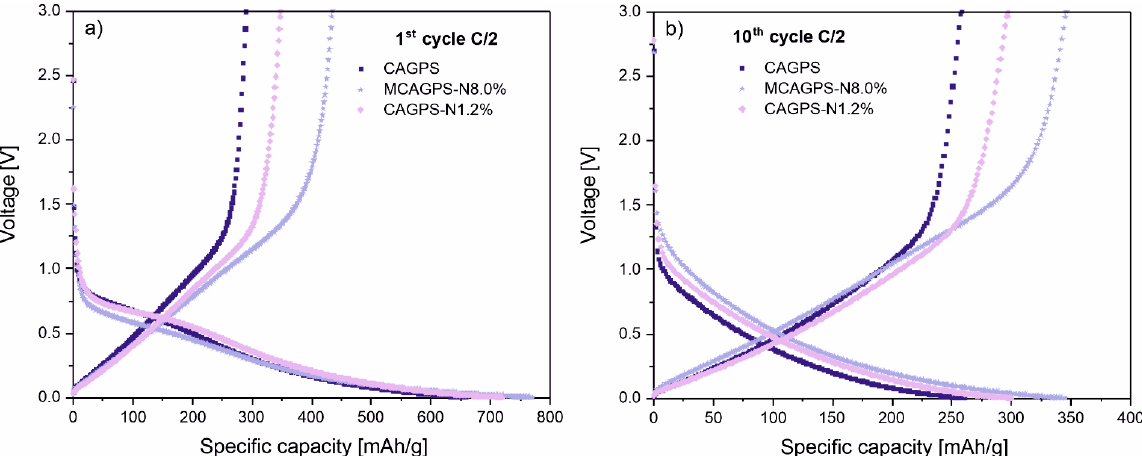
Figure 4. Charge–discharge voltage profiles for the ( a ) 1st and ( b ) 10th cycle of CAGPS-, CAGPS-N1.2%-, and MCAGPS- N8.0%-based electrodes at C/2 current rate (MCAGPS—carbon aerogel made from potato starch modified with melamine; CAGPS-N—carbon aerogel made from potato starch modified by N 2 pyrolysis; CAGPS—pristine carbon aerogel).